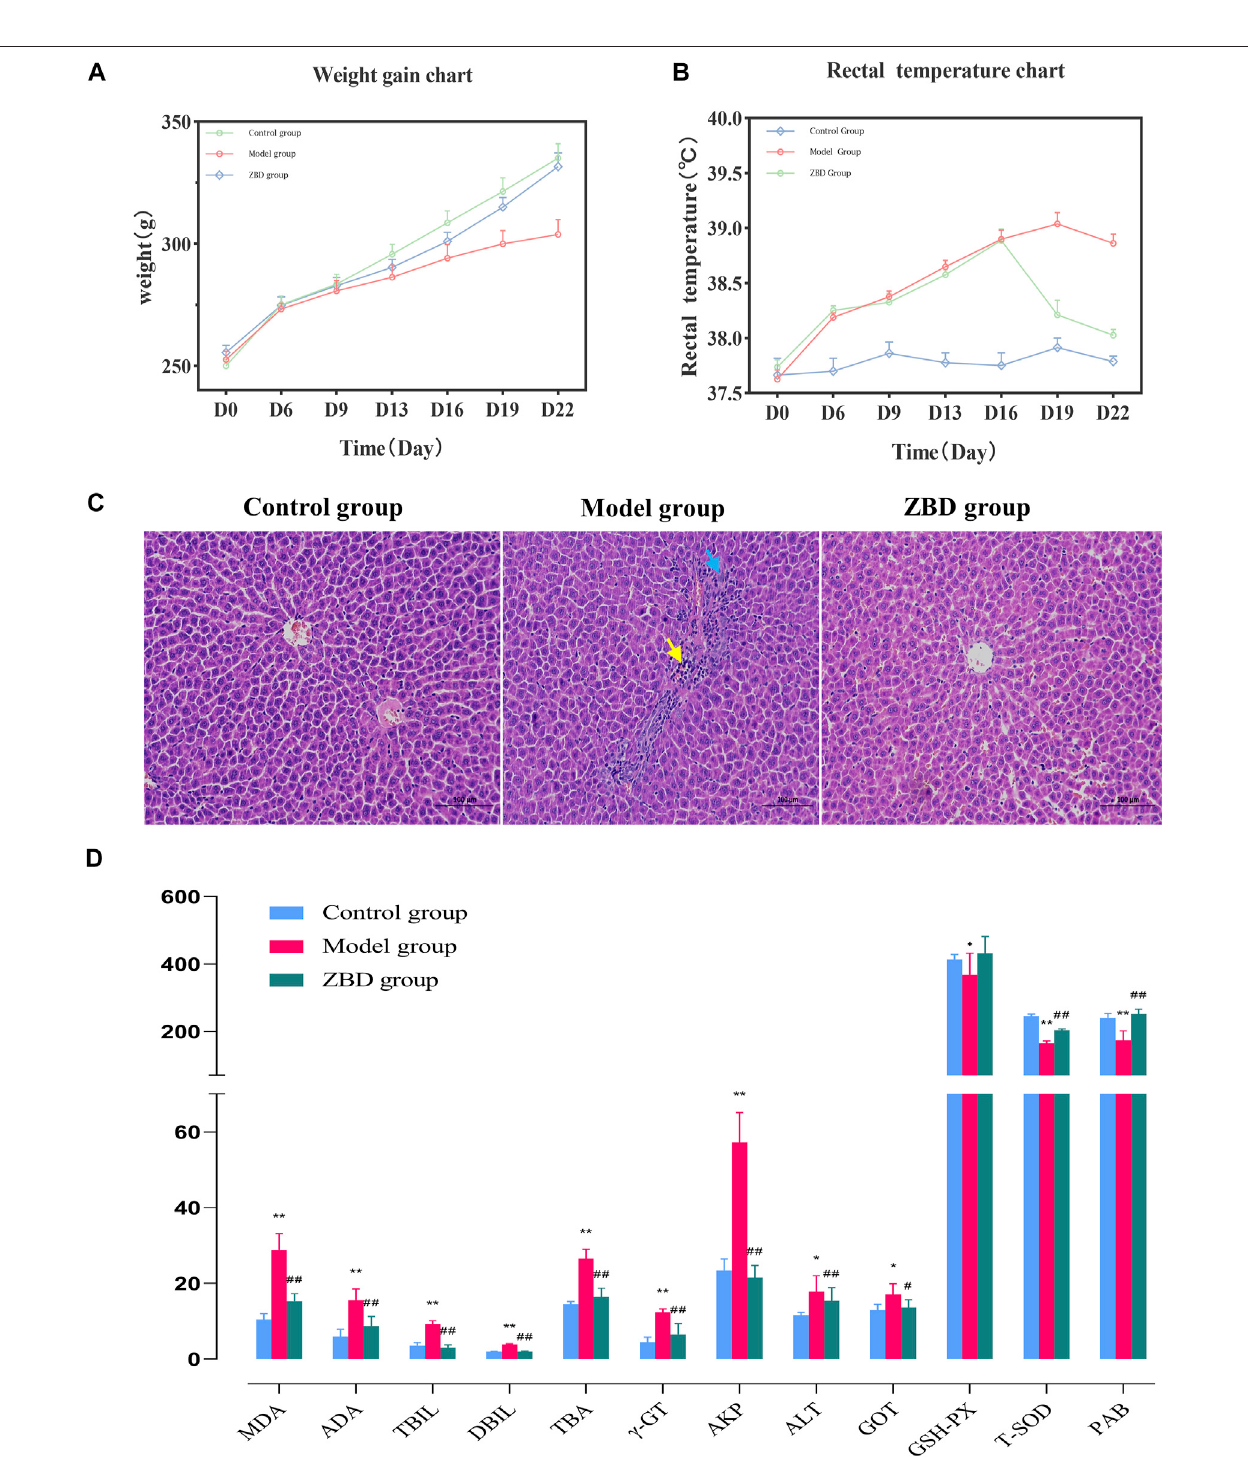
FIGURE1| EffectofZBDonbodyweight,analtemperature,livertissuepathologyandbiochemicalindexesinDHJS. (A) Averageweightinthecontrol,model,and ZBD groups. (B) Average rectal temperature in the control, model, and ZBD groups. (C) H&E staining of liver tissue for histological evaluation (magni fi cation, 100×). (D) Biochemical analysis results for the control, model, and ZBD groups. All the results are presented as the mean ± SD. n = 8 for each group. The model group compared with the control group: * p < 0.05, ** p < 0.01; the ZBD group compared with the model group: # p < 0.05, ## p < 0.01.